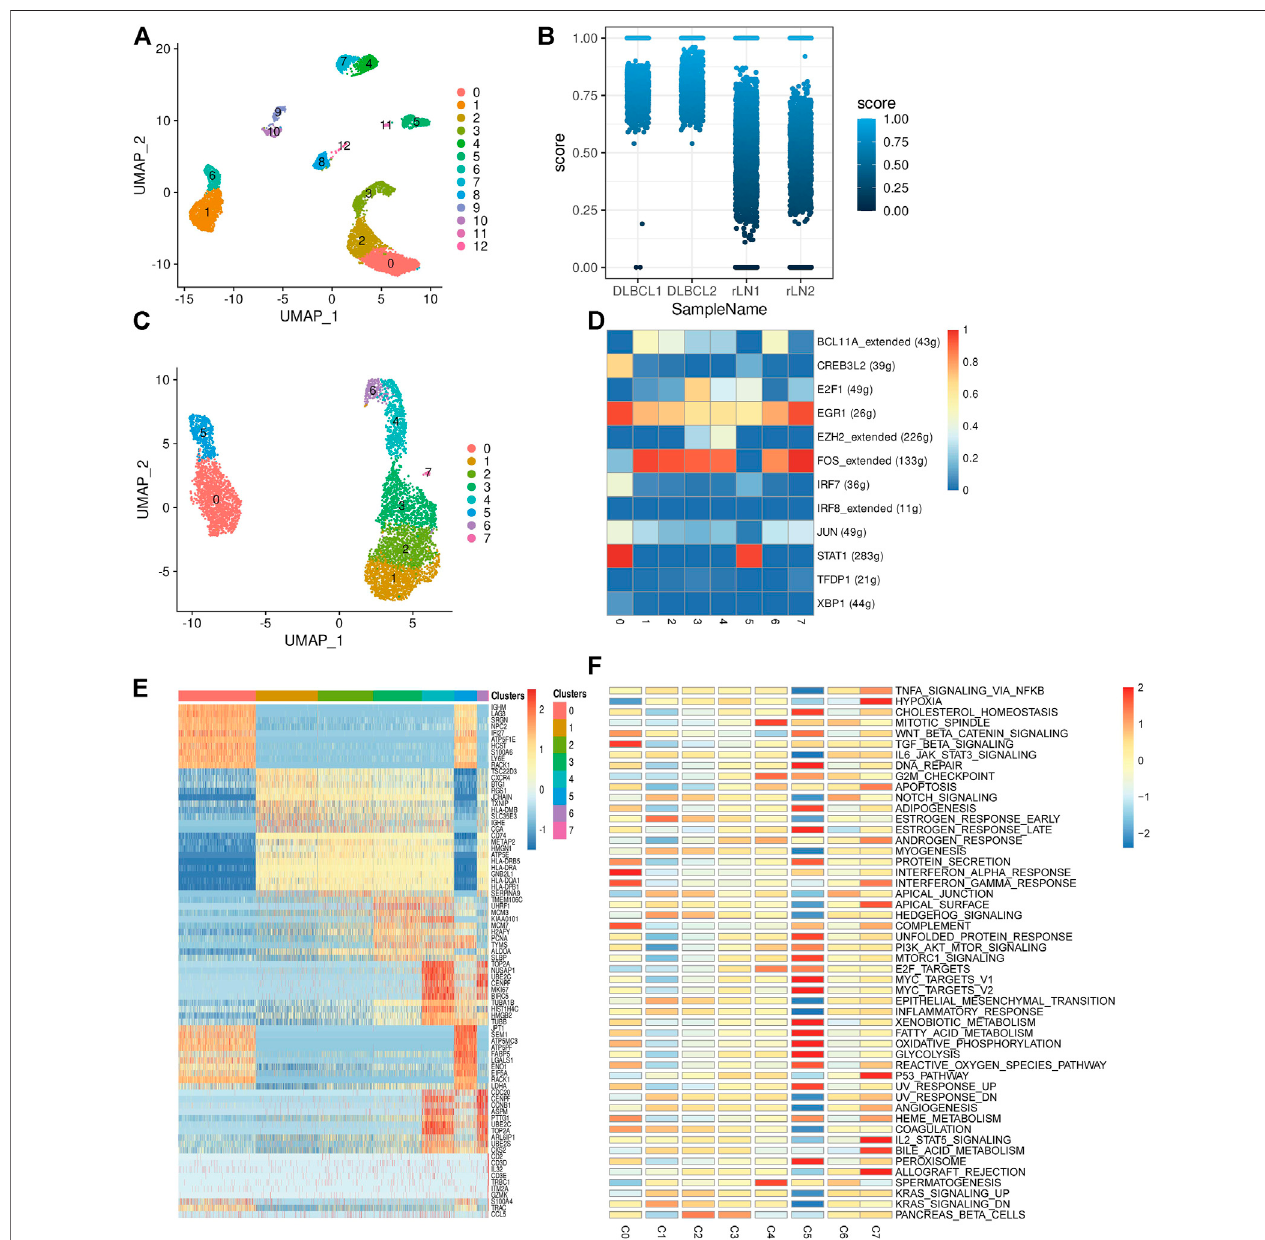
FIGURE2| Transcriptomeheterogeneityin malignant cells. (A) B cellsfrom 4sampleswere combined and visualizedusing UMAP association. Cells werecolored accordingtotheirclusters. (B) IGKCfraction,IGKC÷(IGKC+IGLC2),wascalculatedforeachBcell. Bcellswereclassi fi edas κ +ifthefraction was > 0.5and as λ +ifthe ratio was below 0.5. The percentage of B cells expressing κ or λ was calculated based on the transcriptionally distinct B cell clusters. Nonmalignant B cells contain approximately 50% κ and 50% λ -expressing B cells, whereas malignant B cells contain B cells that uniformly express the κ light chain. (C) The umap plot of malignantBcells. (D) Heat mapofareaunderthecurvescoresforregulationofexpression bytranscription factors imputed withSCENIC. (E) Heatmapshowingthetop 10 differential genes in the 8 malignant B cell subpopulations (Wilcoxon test). (F) Differential activity pathways in the 8 malignant B cell subpopulations (scored by GSVA for each